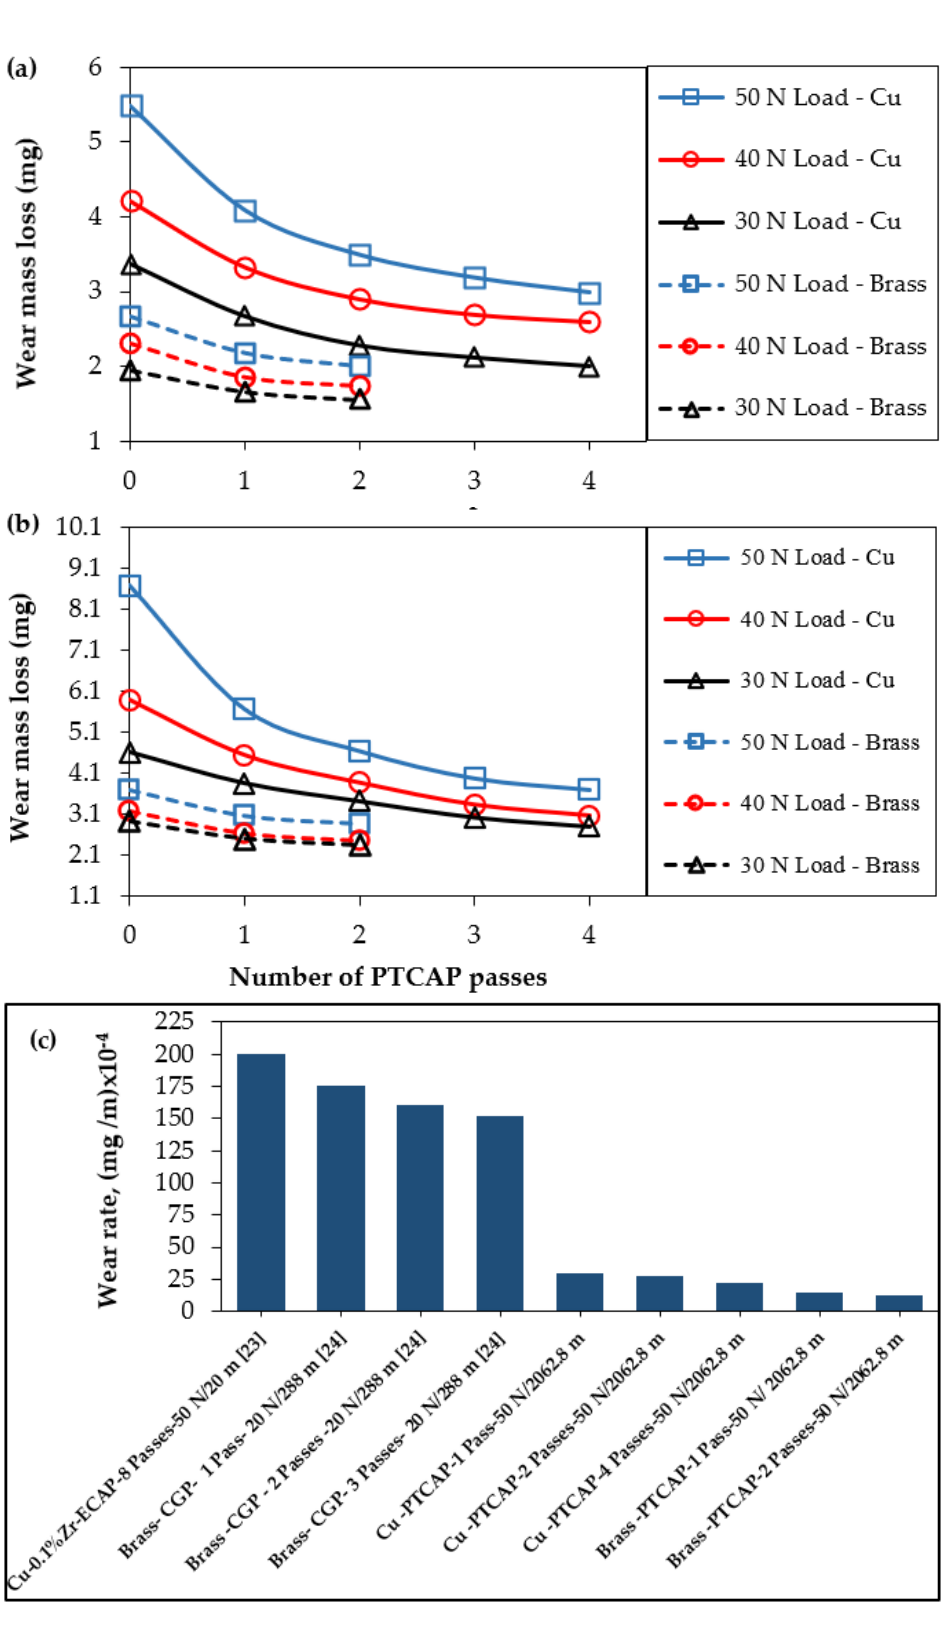
Figure 9. Effect of the number of passes and the applied load on the wear mass loss of the Cu and brass tubes under sliding distances of ( a ) 1375.2, ( b ) 2062.8 m; ( c ) shows a comparison with previous works.